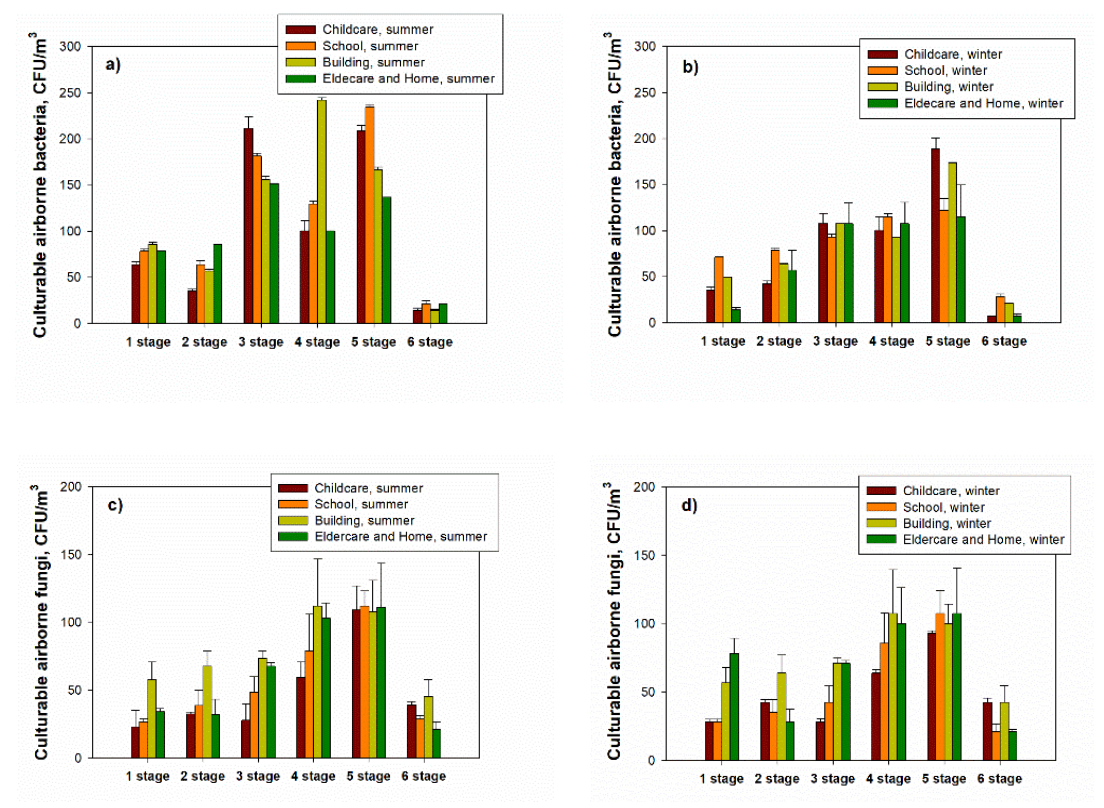
Figure 6. Culturable airborne bacteria ( a and b ) and fungi ( c and d ) during summer and winter seasons in different environments (childcare facilities, schools, commercial buildings and elderly and homes) using the six-stage Anderson impactor.